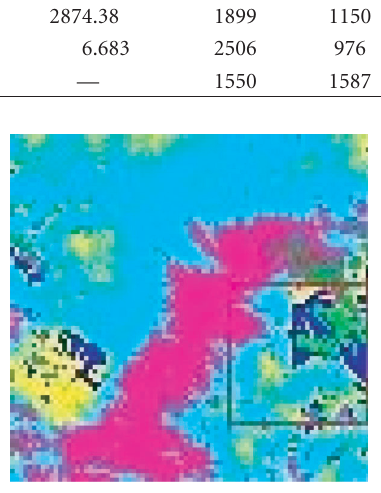
Figure 4.5. Indications of the smoke plume prominently in purple and the associated burnt scar in dark green in the green slice range (32 to 63) or blue slice range (64 to